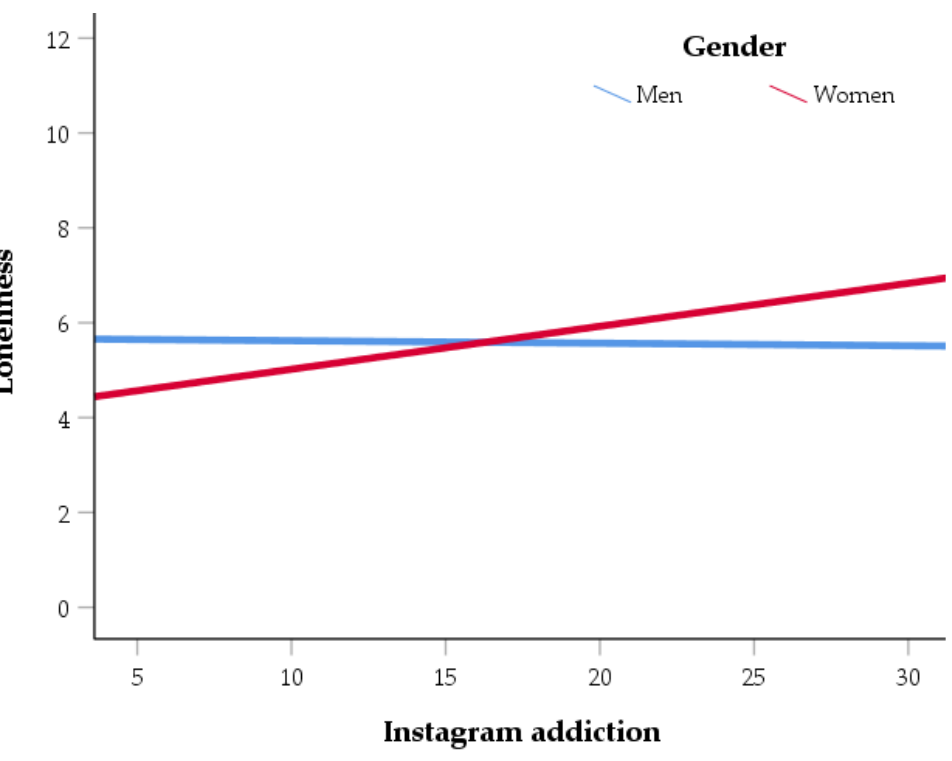
Figure 2. Interaction effect between Instagram addiction and gender on loneliness.